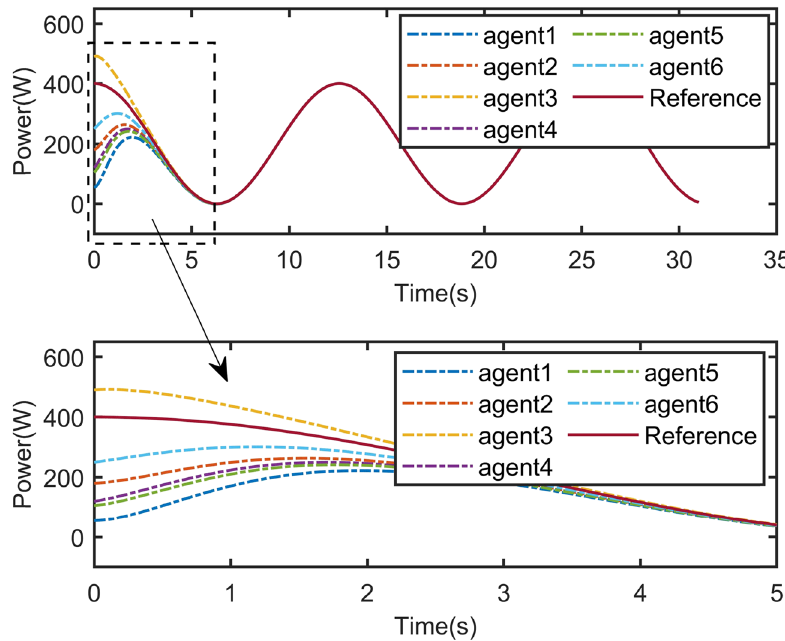
Figure 4: Multi microwave source agent power consistent